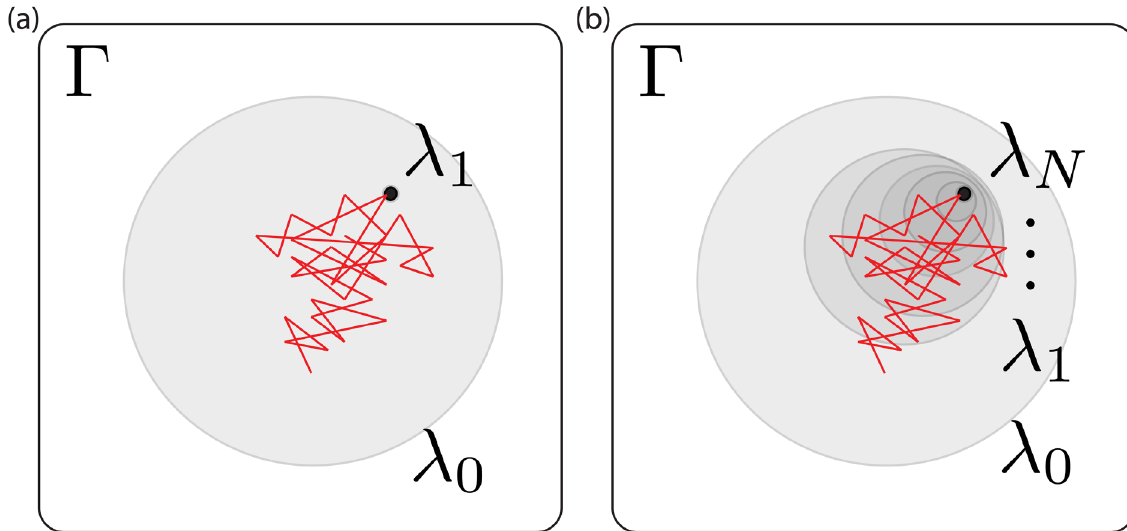
Figure 3. Phase space overlap between the states in a thermodynamic path for removing restraints with λ . Γ represents the phase space that contains all the configurations for all the states in the path. λ and λ (left) or λ (right) represent the end states along the path, 0 1 N each shaded region represents a state in phase space and the red lines represent the configurations visited by the simulation run in the λ 0 state. The restrained state is a subset of the unrestrained one. ( a ) and ( b ) represent simulations with different numbers of intermediate states along the path between a fully restrained state ( λ ( a ) or λ ( b )) and an unrestrained state ( λ ). In ( a ), the simulation (red) only visits very few 1 N 0 configurations consistent with the restrained state – i.e, there is poor phase space overlap – indicating a need for more intermediate states, otherwise any free energy estimates will be subject to very high uncertainties; in ( b ) there is still almost no overlap between the simulation and states consistent with λ , but there is overlap with the next shaded region, λ , indicating the potential for overlap and accurate free energy N 1 estimates. Thus simulations run in each shaded region are more likely to have a bigger phase space overlap with λ than simulations run in N . λ 0